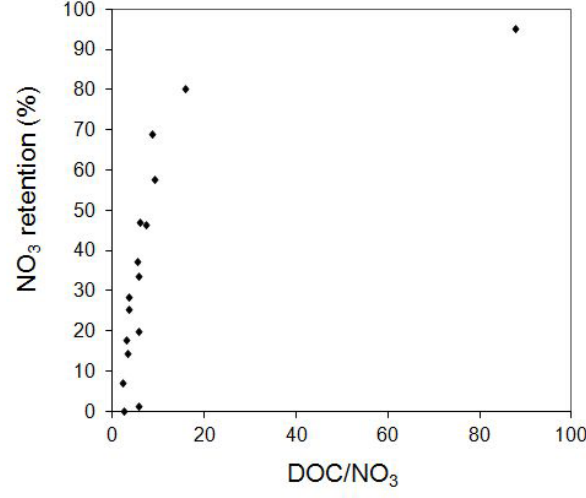
Fig. 10. Scatterplot of the percentage of NO 3 retention versus the DOC:NO 3 calculated using the mean concentrations measured in the stream water